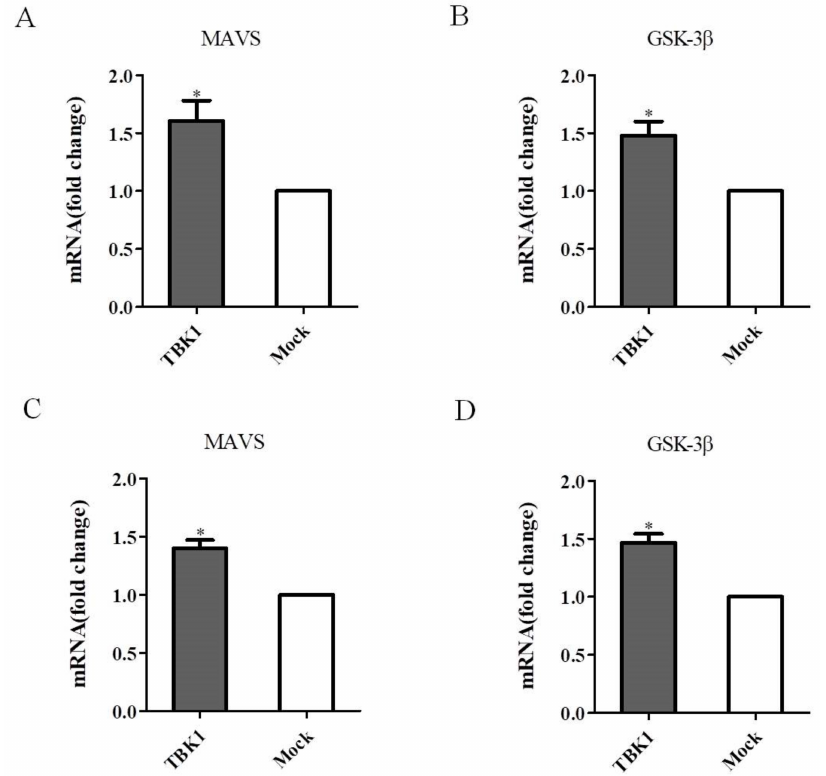
Figure 7. MAVS and GSK-3 β expression levels in DEF cells. ( A , B ) DEF cells were transfected with pCAGGS-TBK1 expressing TBK1 for 48 h and MAVS and GSK-3 β expression levels were detected by qRT-PCR. ( C , D ) DEF cells were transfected with pCAGGS-TBK1 expressing TBK1 for 24 h, and then infected with DEV at a MOI of 0.1. DEF cells were then collected and MAVS and GSK-3 β expression levels were detected by qRT-PCR. Significant differences in MAVS and GSK-3 β expression levels between TBK1-transfected and mock-transfected DEF cells were assessed using the Student’s t -test. Mean ± SD of three technical replicates are shown. * p <